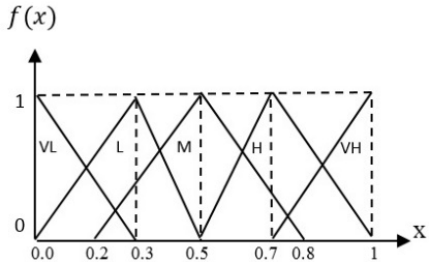
Figure 4. Membership functions for importance weights of criteria. Table 2. List of linguistic variables and their corresponding fuzzy numbers for importance weights. Linguistic